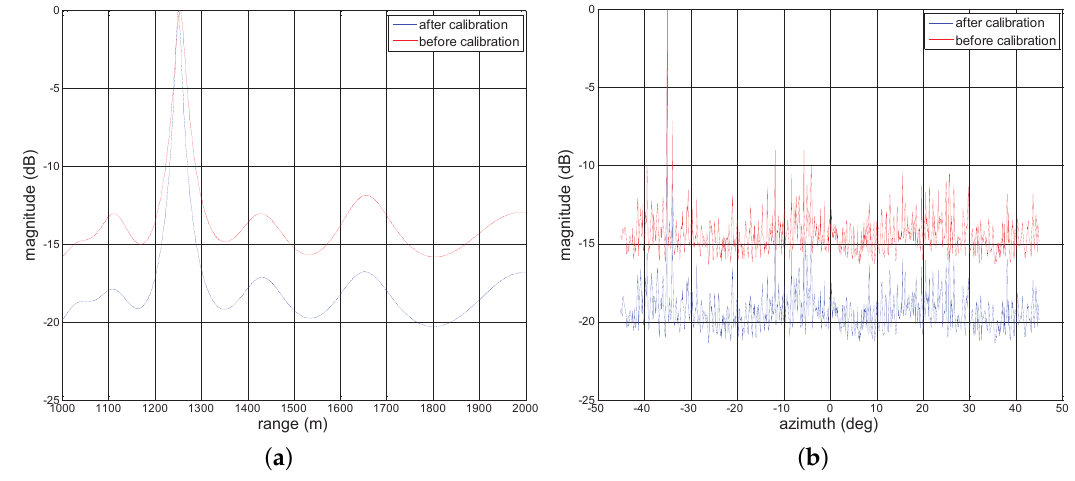
Figure 9. One-dimensional MVDR spatial spectrums for a source with estimated location ( 1251m, − 35 ◦ ) under SNR = 10 dB, ( a ) θ = − 35 ◦ ; ( b ) r = 1251 m.